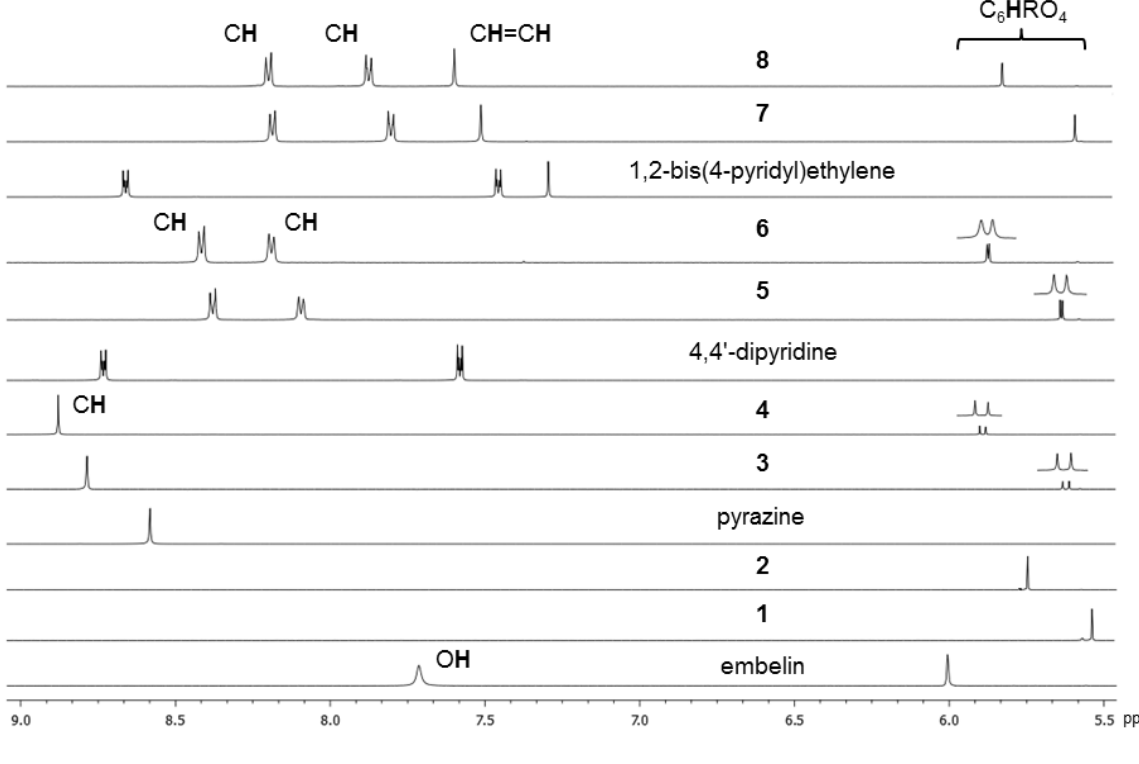
Figure 4. Molecular structure of the cis - and trans -isomers of the metalla-rectangle 3 .